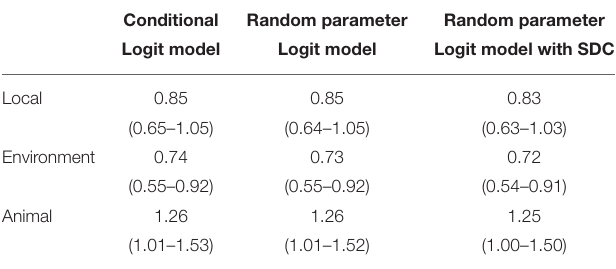
TABLE 5 | Willingness to pay ($) for different characteristics of differentiated cow’s milk a